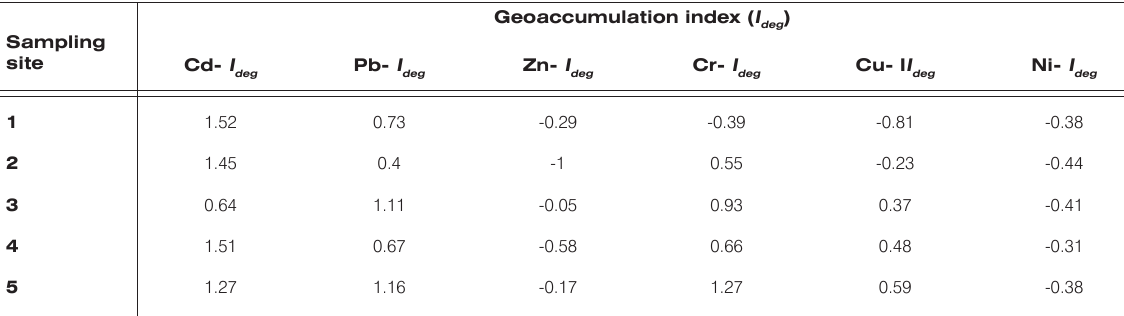
Figure 4. Examples of metal distribution in particular fractions (Kielce Lake, between July 2008 and May 2009), where a) Mn, b) Zn, c) Cu, d) Ni, e) Cr, f) Pb, g) Fe and h) Cd. Table 3. Mean values of the geoaccumulation index of bottom sediment contamination in Kielce